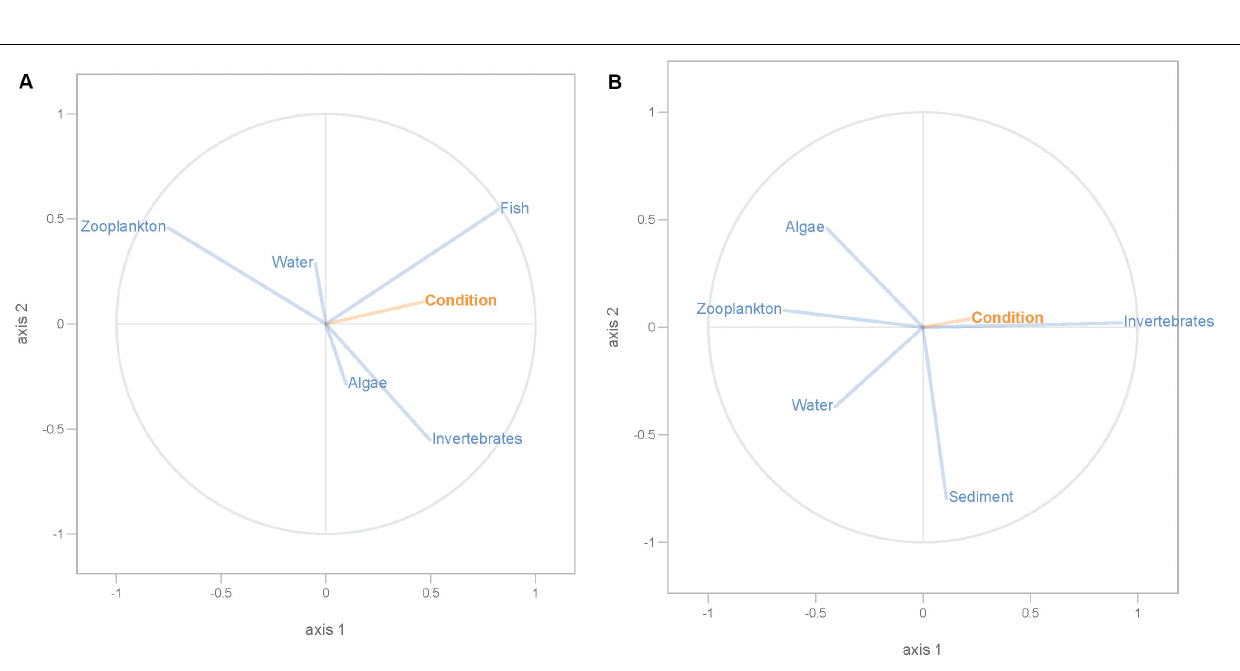
Frontiers in Ecology and Evolution |